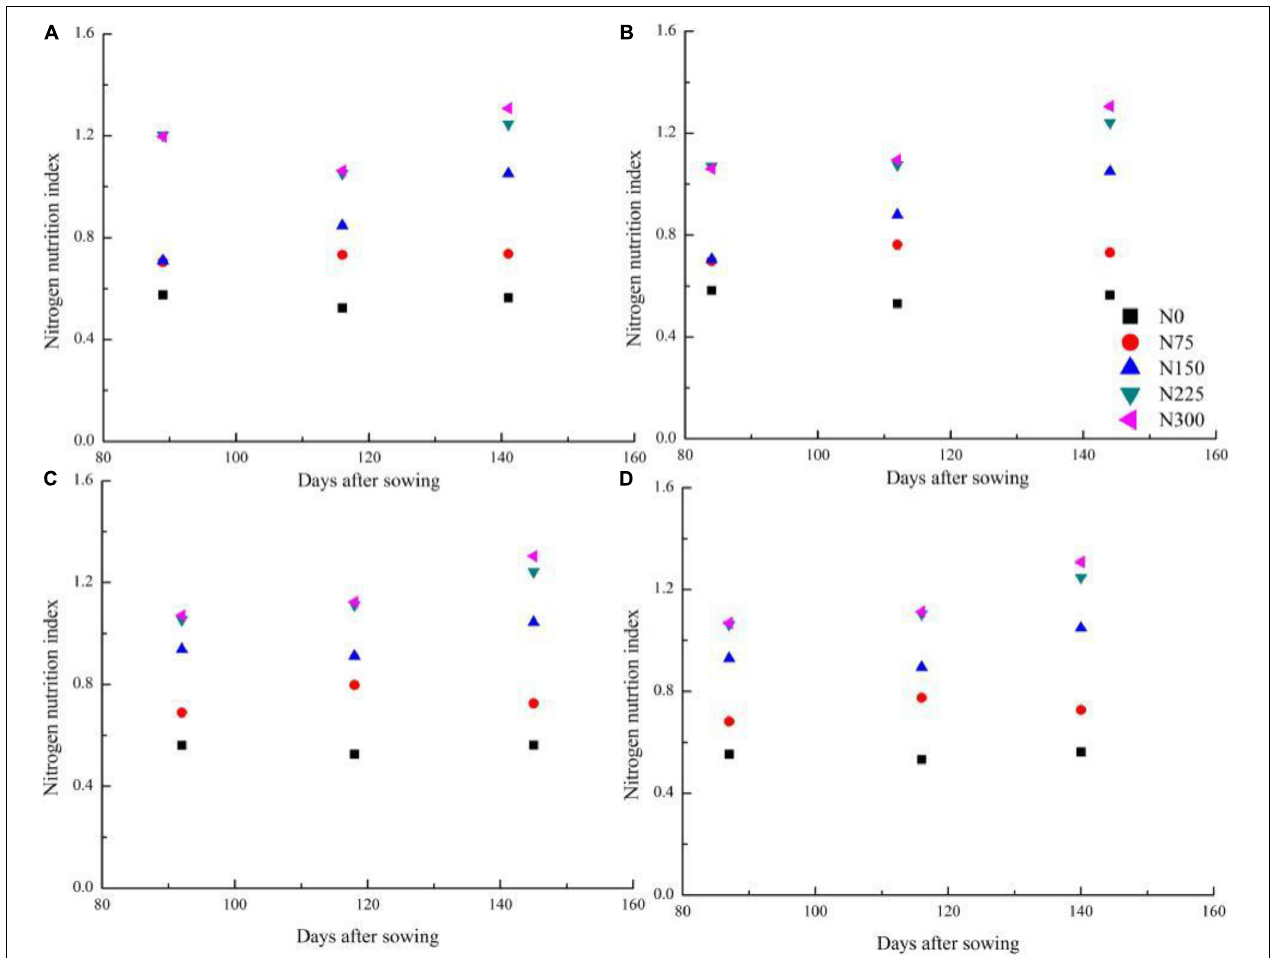
FIGURE 3 | Changes of nitrogen nutrition index during the vegetative period of winter wheat among different cultivars and nitrogen application rates on 2016–2018 growth seasons. [ (A) 2016–2017 AK58; (B) 2016–2017 YM58; (C) 2017–2018 BN207; (D) 2017–2018 WM28].